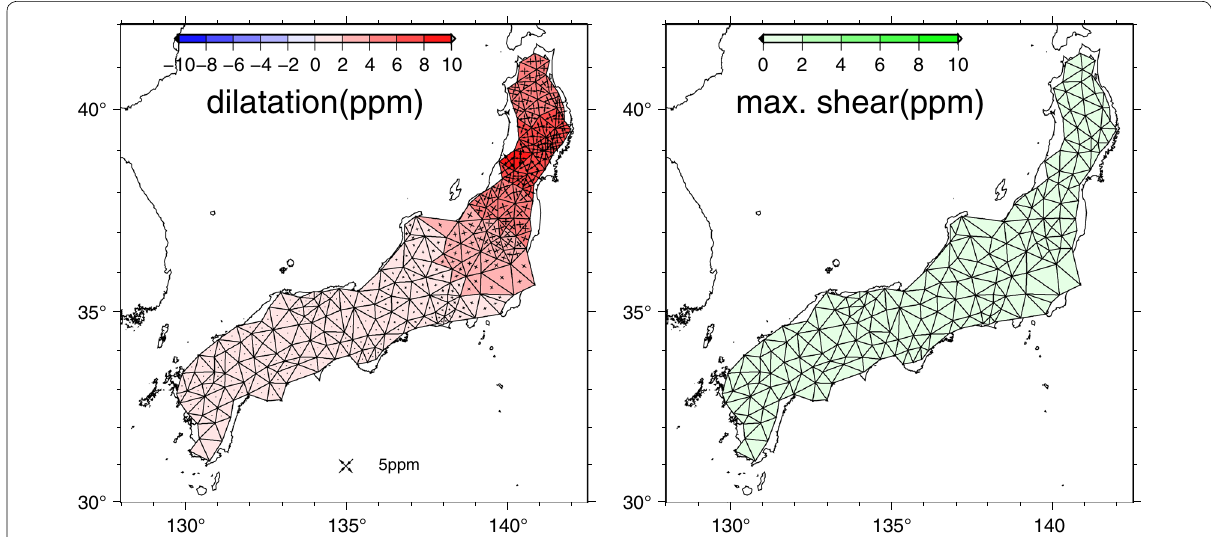
Fig. 6 Strain bias due to a 5 cm error of the Shionohara baseline. a Arrows indicate principal strain axes, and dilatational bias is shown by colors. b + Bias in the maximum shear